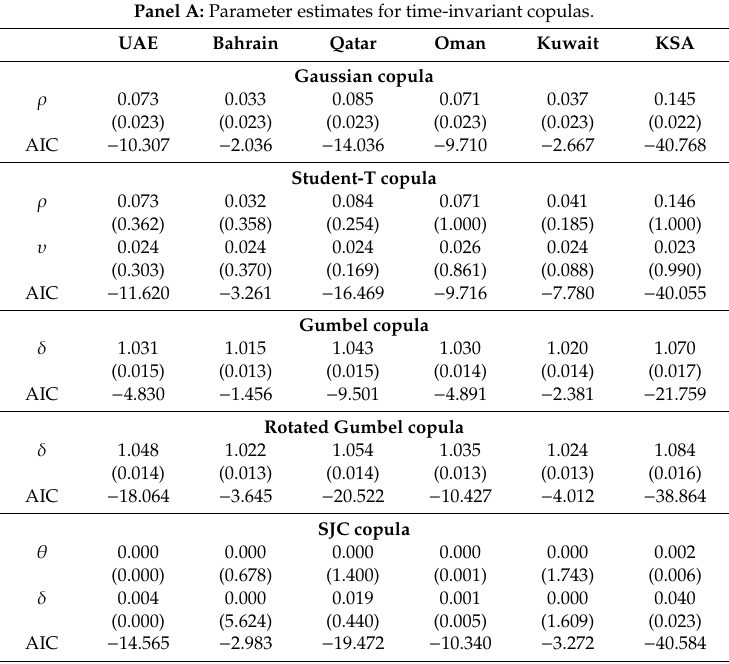
Table 3. Parameter estimates for the copula between the GCC and S&P 500 banking sector markets. Panel A: Parameter estimates for time-invariant copulas.